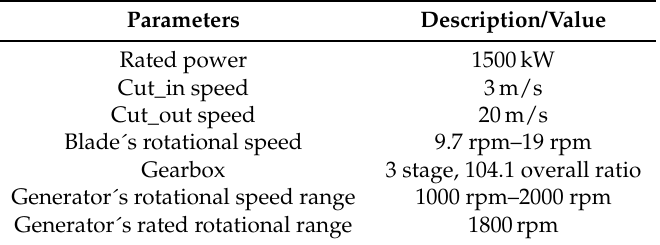
Table 2. Parameters for wind turbines in the two wind power plants.